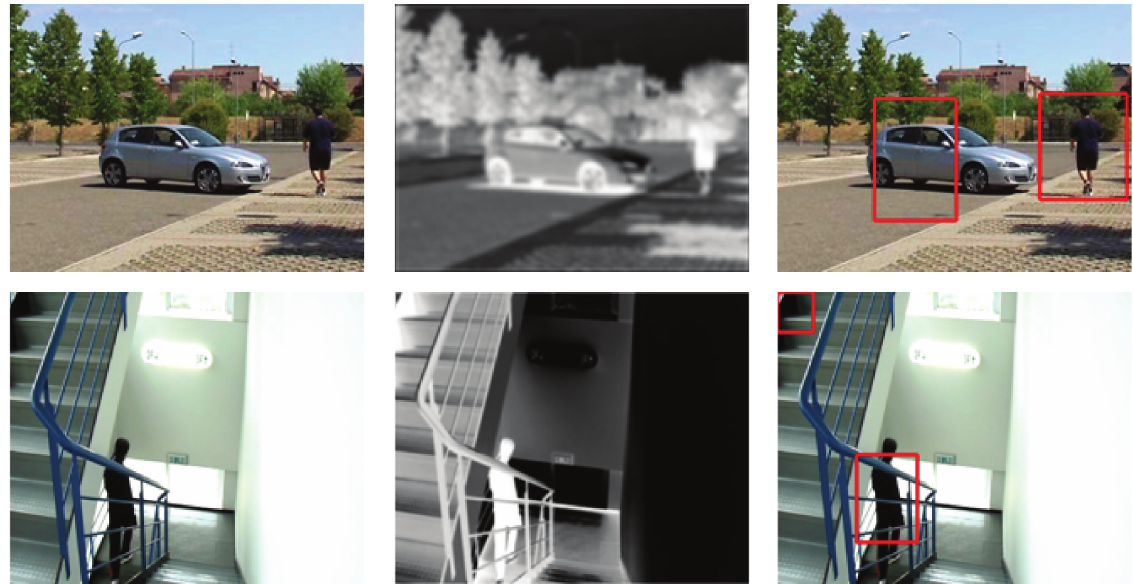
Figure 10: Videos (1) and (2): results using Gaussian spatial model by coalescing Laplacian of Gaussian (LoG) filter and Gaussian filter for different videos.